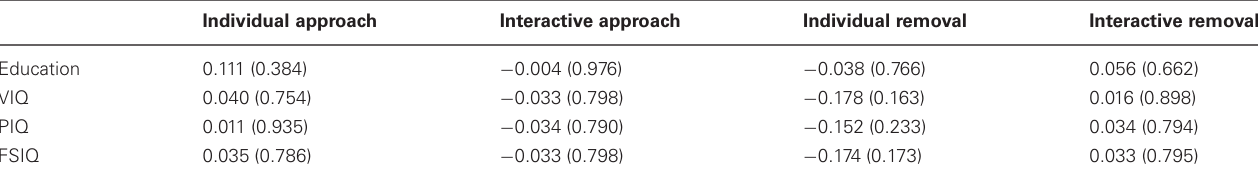
Table 2 | Correlations between IMR and education/IQ (p-value in parentheses). Individual approach Interactive approach Individual removal Interactive